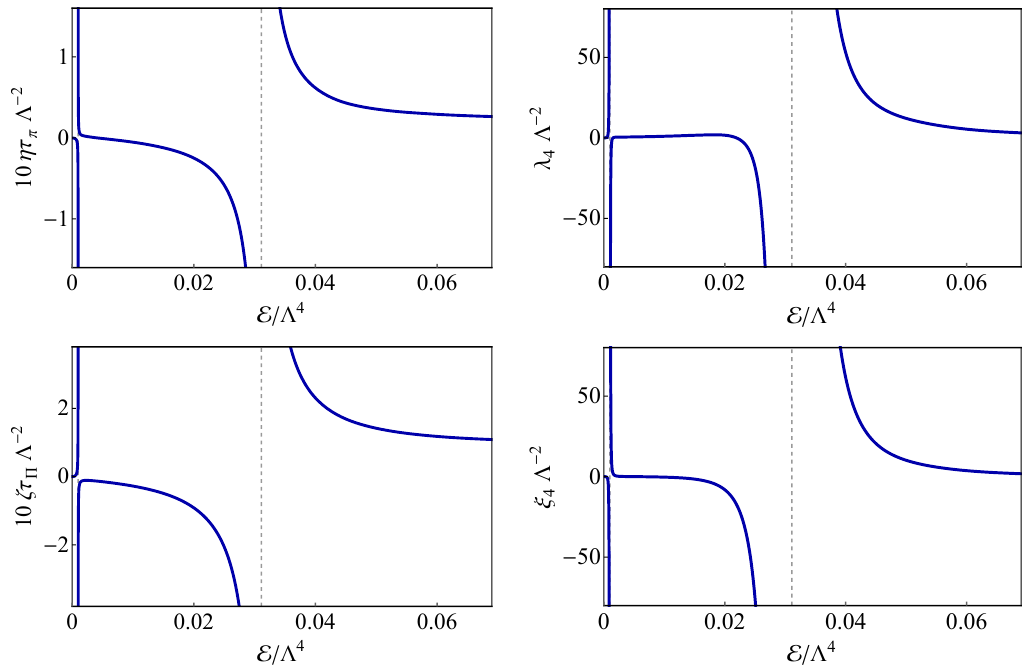
Figure 35 . Second-order coe(cid:14)cient entering the MIS-type formulation of hydrodynamics as a function of the energy density. The vertical grey lines indicate the values at which the speed of sound crosses